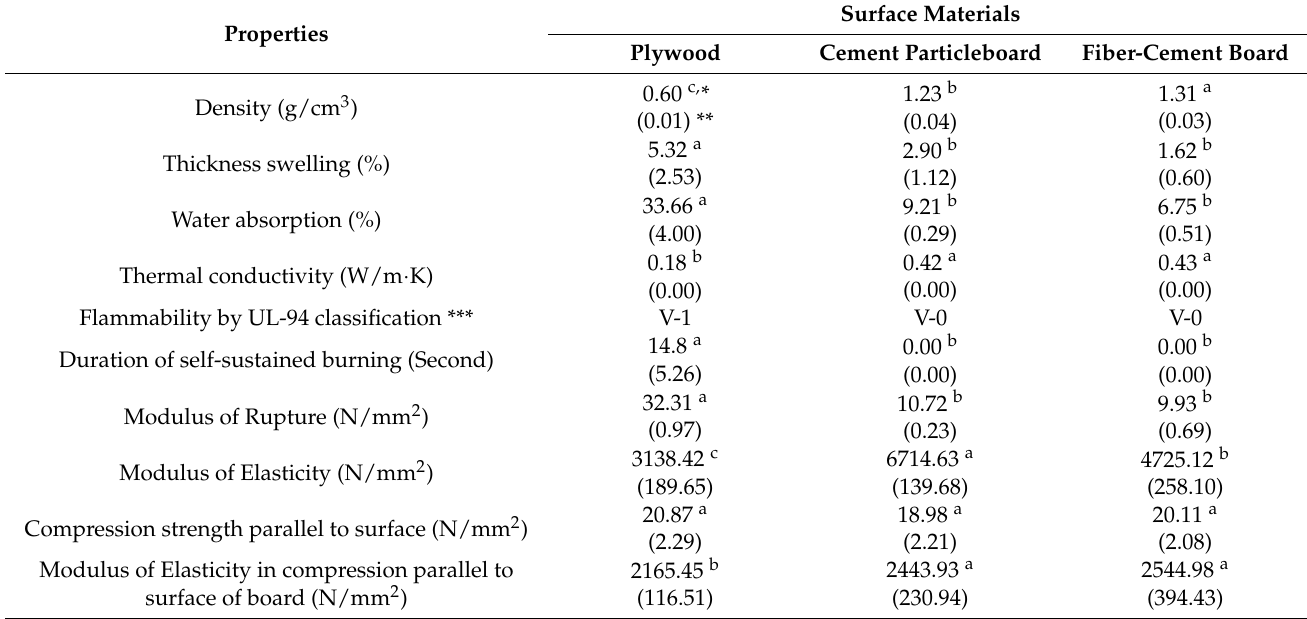
Table 4. Properties of the surface materials used in this